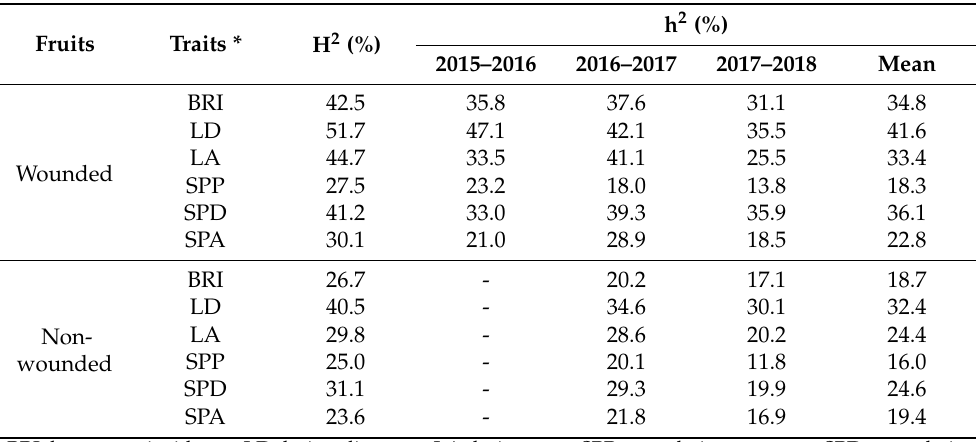
* BRI, brown rot incidence; LD, lesion diameter; LA, lesion area; SPP, sporulation presence; SPD, sporulation diameter; SPA, sporulation area.